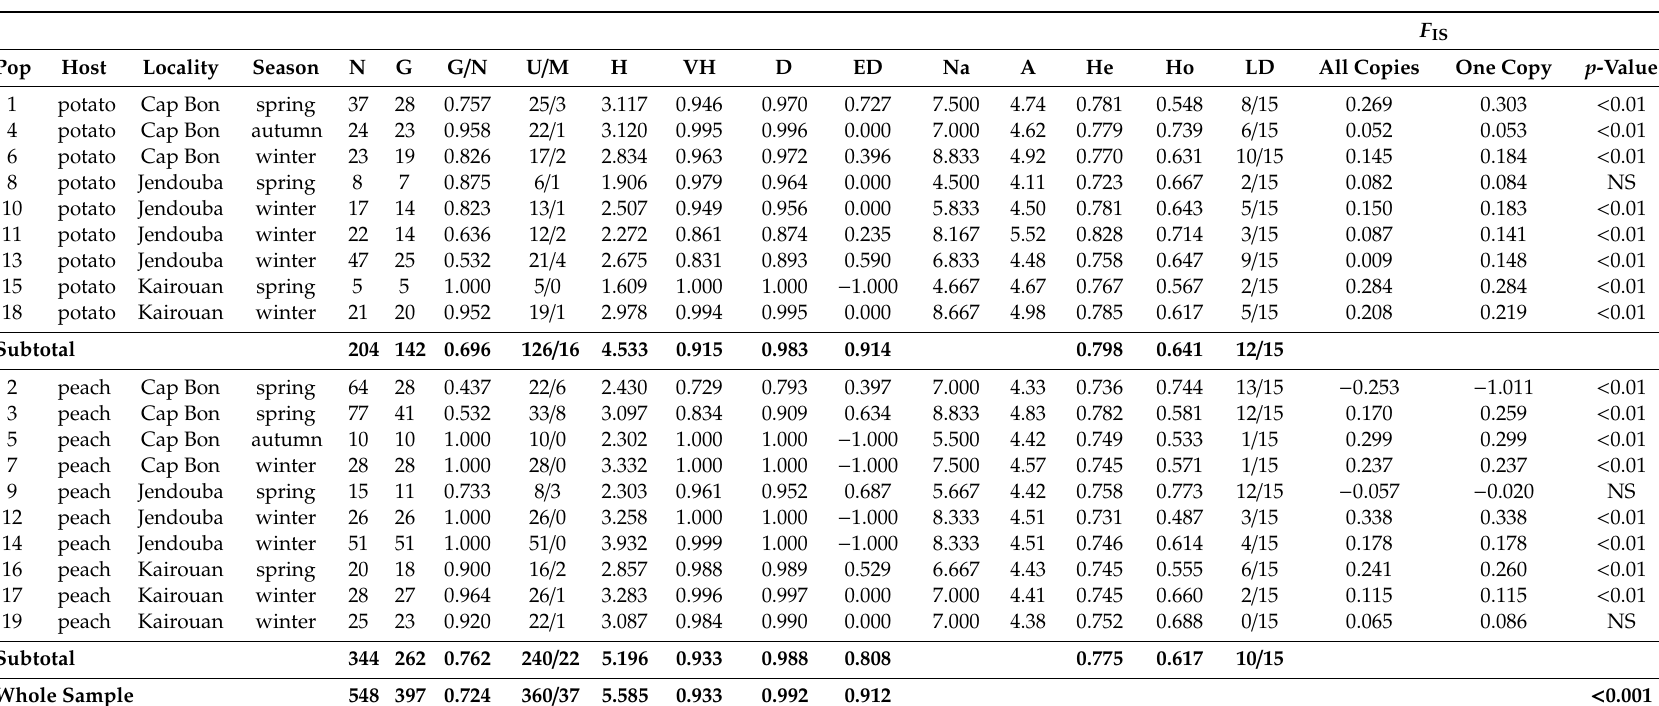
Table 2. Genetic diversity indexes of M. persicae populations collected from peach and potato in Tunisia. Population (Pop), number of individuals analyzed (N), total number of multilocus genotypes (G), clonal diversity (G / N), ratio of unique / multicopy genotypes (U / M), Shannon diversity index (H) and its evenness (VH), Simpson diversity index (D) and its evenness (ED), mean number of alleles (Na), allelic richness over loci (A), mean expected heterozygosity (He), observed heterozygosity (Ho), loci under disequilibrium out of possible tests (LD), inbreeding coe ffi cient ( F IS ) considering all clonal copies or one single copy per